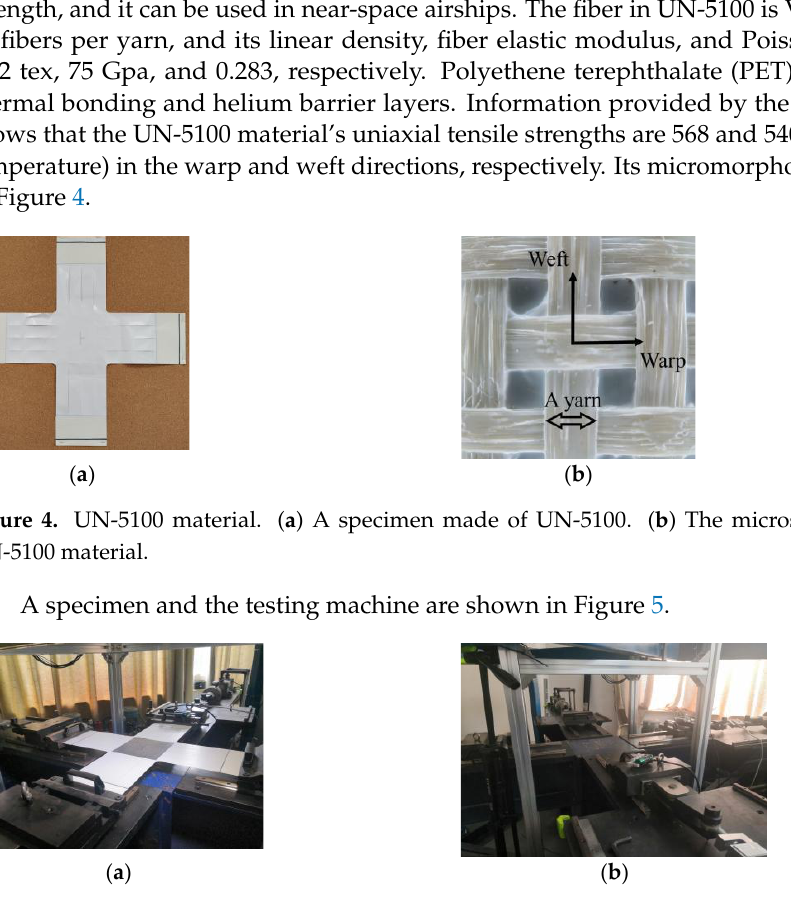
Figure 6. Biaxial specimen (units in millimeters).